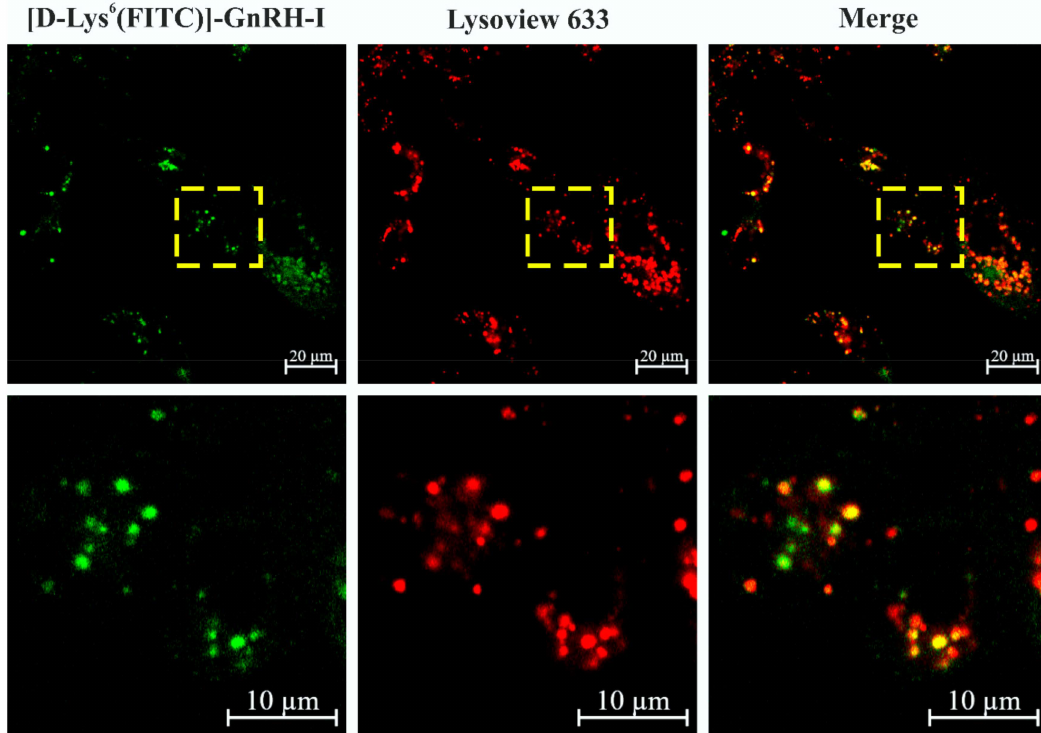
Figure 6. Colocalization of [ d -Lys 6 (FITC)]–GnRH-I and the lysosomes in EBC-1 cells. The green fluorescent signal of [ d -Lys 6 (FITC)]–GnRH-I (10 µ M, 24 h) showed strong colocalization with the red fluorescent signal of lysosome marker Lysoview